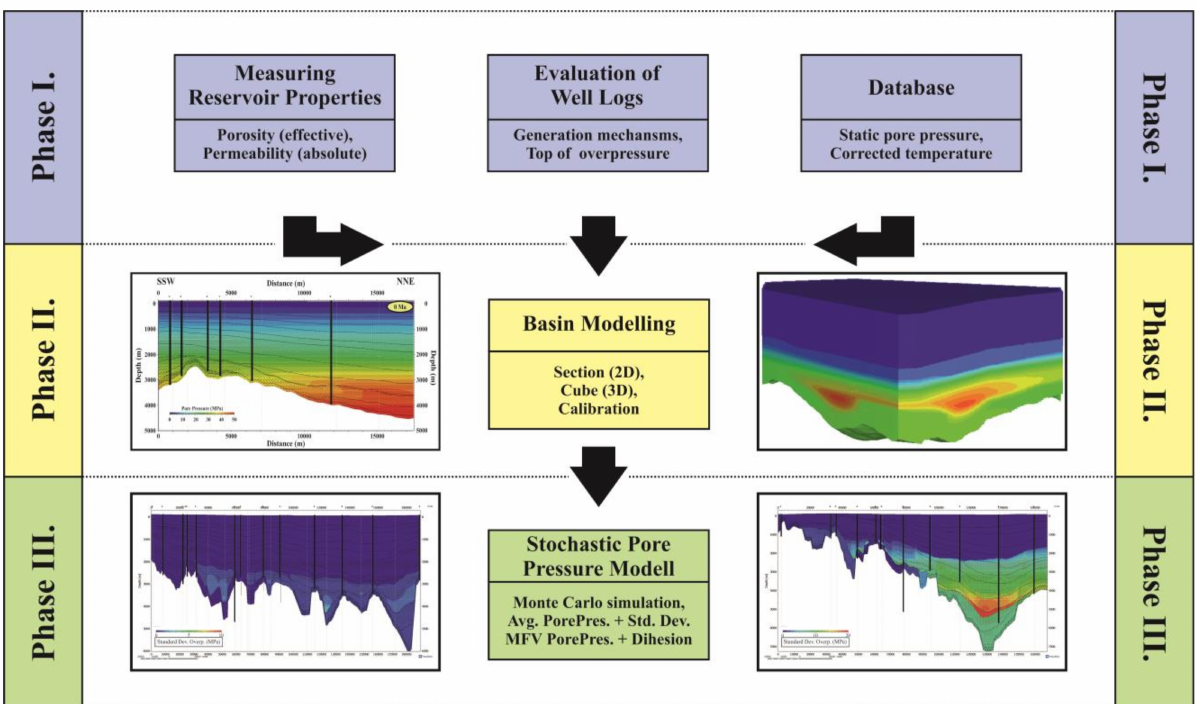
Figure 4. Developed workflow with the three main phases that can deliver the stochastic pressure models to predict and evaluate the subsurface pressure regime on a basin